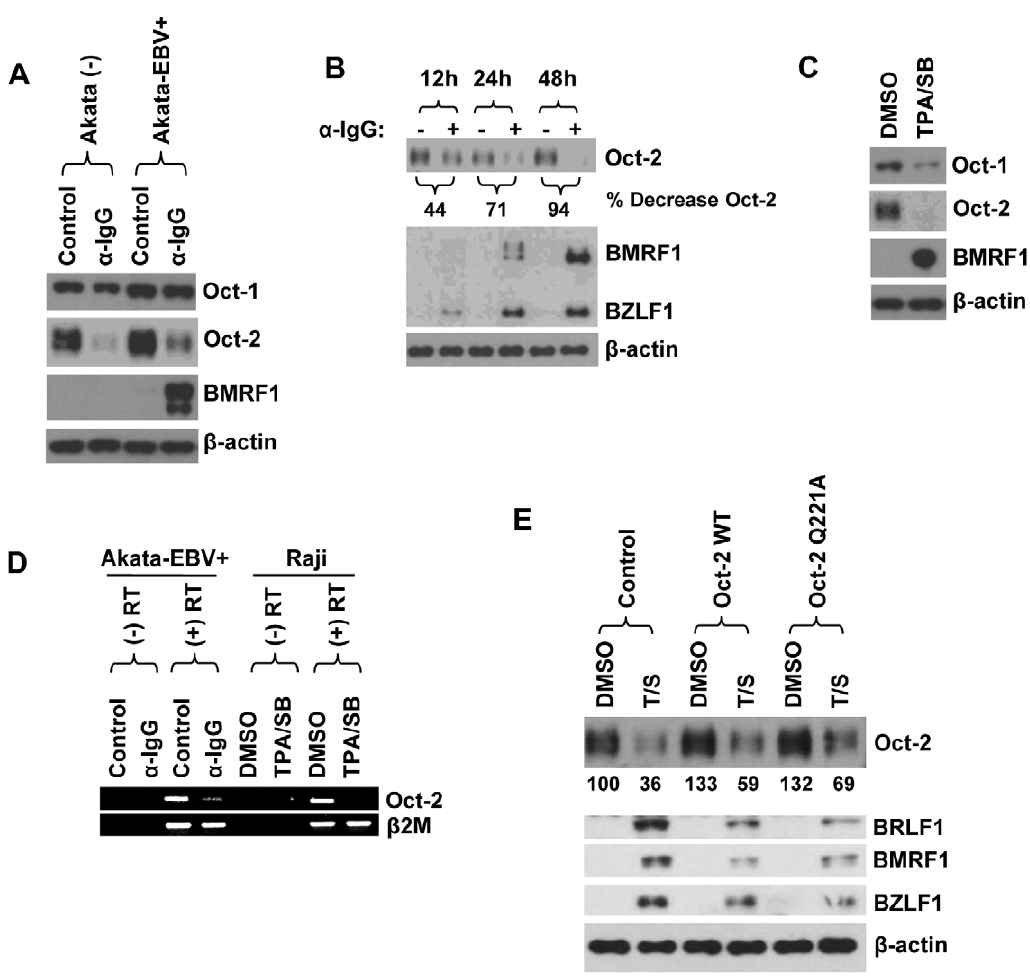
Figure 9. Lytic reactivation stimuli decrease Oct-2 expression. (A) The EBV-negative B-cell line, Akata (-), and the EBV-positive B-cell line, Akata-EBV + , were lytically induced with anti-IgG (20 m g/mL). Immunoblot analysis was performed two days after treatment to compare the levels of endogenous Oct-1, Oct-2, viral BMRF1 and b -actin (loading control). (B) Akata-EBV + cells were lytically induced with anti-IgG (20 m g/mL) and harvested at 12, 24 and 48 hour intervals. Immunoblot analysis was performed to compare the levels of endogenous Oct-2, BMRF1, BZLF1, and b - actin (loading control). Oct-2 protein bands were quantified using ImageJ software and represented as percentage decrease of Oct-2 expression (relative to untreated cells at each time point) as shown below the Oct-2 immunoblot. (C) Raji cells were lytically induced with the chemical inducers TPA (20 ng/mL) and sodium butyrate (3 mM). Immunoblot analysis was performed two days after treatment to compare the levels of endogenous Oct-1, Oct-2, viral BMRF1 and b -actin (loading control). (D) The expression level of the Oct-2 gene was examined by RT-PCR in Akata-EBV + and Raji cells lytically induced either with anti-IgG (20 m g/mL) or chemical inducers (20 ng/mL TPA/3 mM sodium butyrate) for 48 hours. The b 2 -microglobulin gene was used as a control. (E) Raji cells were infected with lentivirus vectors (CDH713) which express either wild-type Oct-2 or mutant Oct-2 (Q221A) proteins driven by the MSCV (murine stem cell virus) promoter and selected for 7 days using puromycin. Cells were then treated with 20 ng/mL TPA and 3 mM sodium butyrate for 24 hours to induce lytic reactivation. Immunoblot analysis was performed to compare the levels of Oct-2, BZLF1, BRLF1, BMRF1, and b -actin (loading control). The amount of Oct-2 protein expression was quantitated using ImageJ software and represented as a numerical value below the Oct-2 immunblot. The Oct-2 protein level in untreated cells infected with the control lentivirus was set at